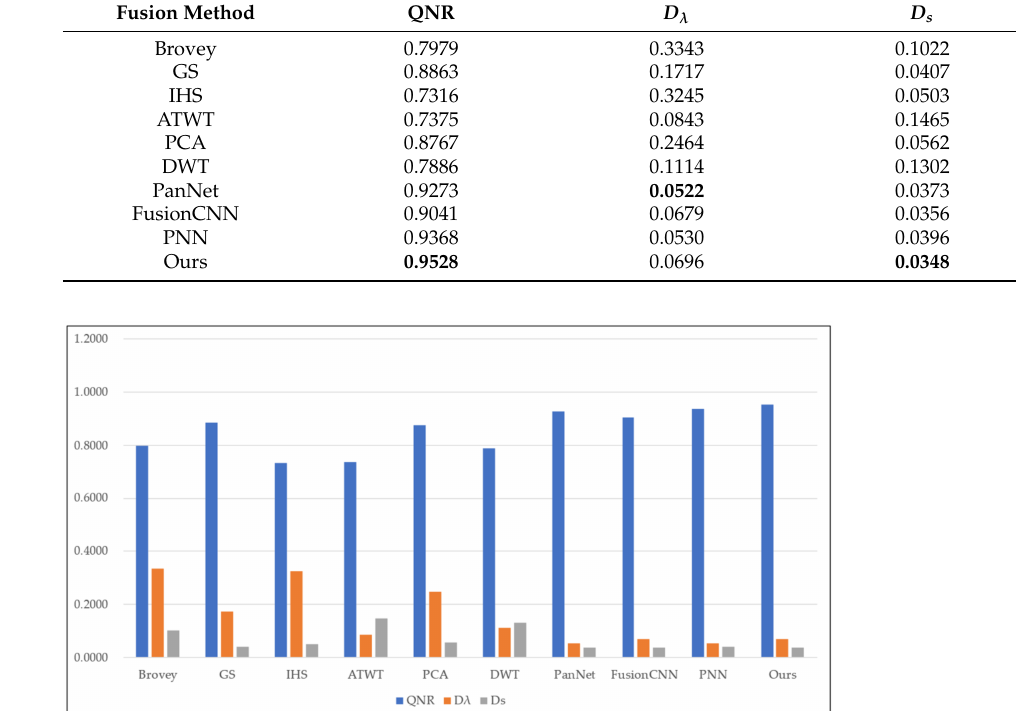
Figure 13. Fusion results for the third group of remote sensing image data. Table 4. The third group evaluation indexes of different fusion results.